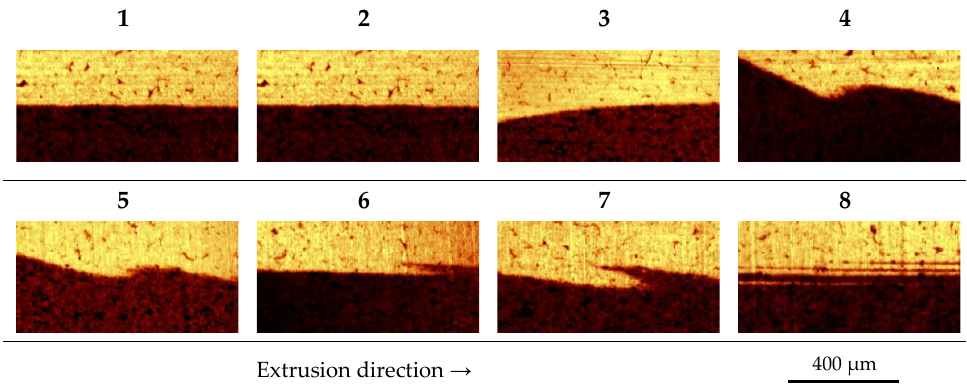
Figure 9. Raman images (400 × 800 µm, 101 × 201 spectra) at the different positions 1 to 8 of the melt imprint.